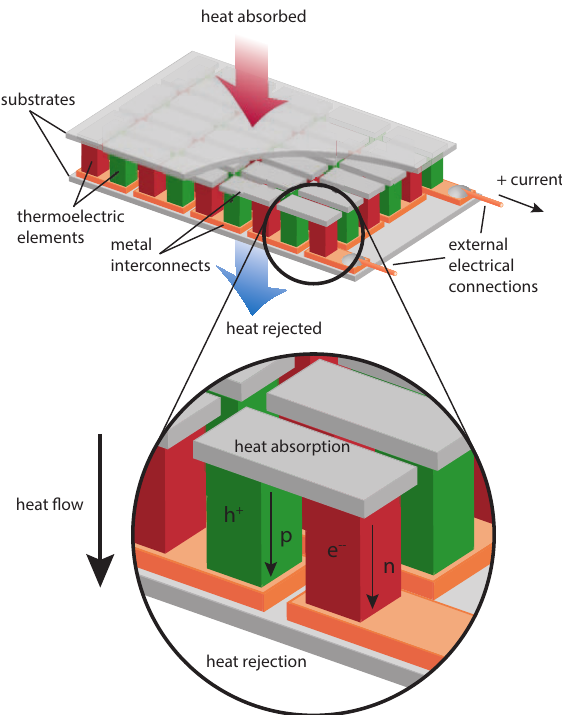
Figure A1. Schematic of a typical thermoelectric module [36]. Note the p-n junction (green and red), the conductive tabs (grey and orange on the hot and cold side, respectively) and the external supporting layers